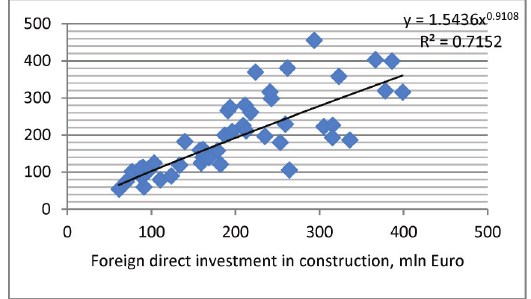
Fig. 3. The correlation between foreign direct investment in con- struction and value added by the Estonian construction sector